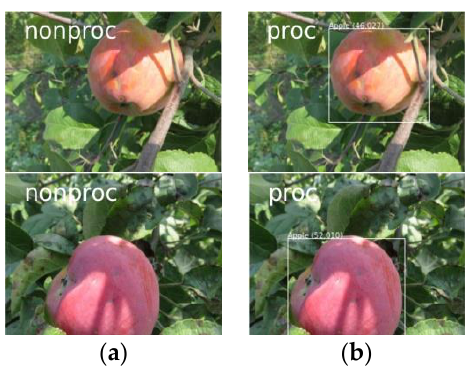
Figure 3. Detecting apples with shadows, glare, and overlapping leaves by YOLOv3 without pre-processing ( a ) and with pre-processing ( b ).